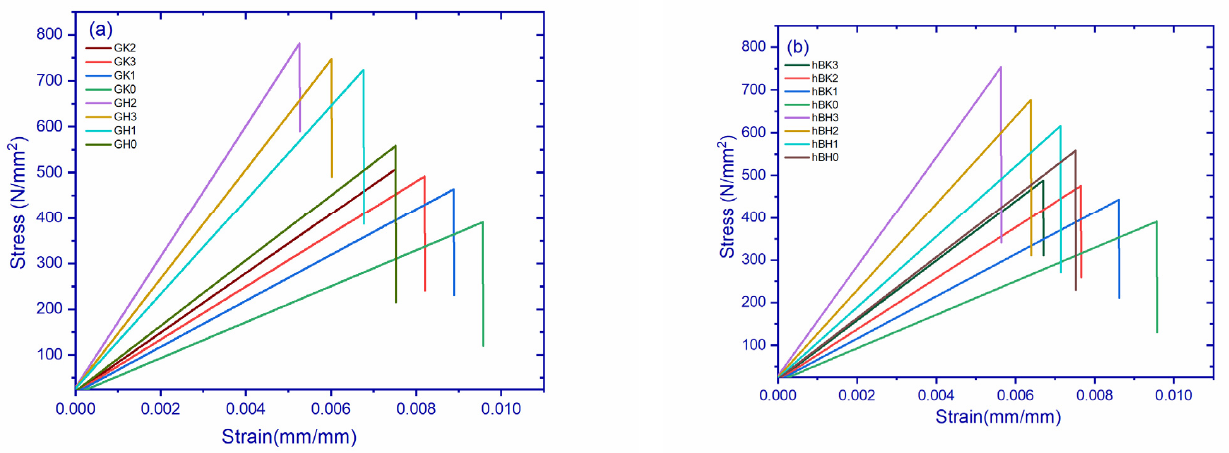
Figure 3. ( a ). Stress–strain curves of graphene filled composites. ( b ) Stress–strain curves of hBN- composites. filled composites.